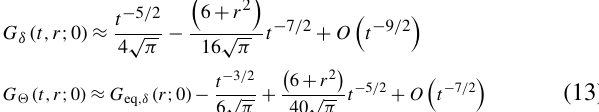
From these, the general surface results including advec- tion are obtained with r → | x − α t | , i.e., G δ ( t, x ; 0) = G δ, dif ( t, | x − α t |;